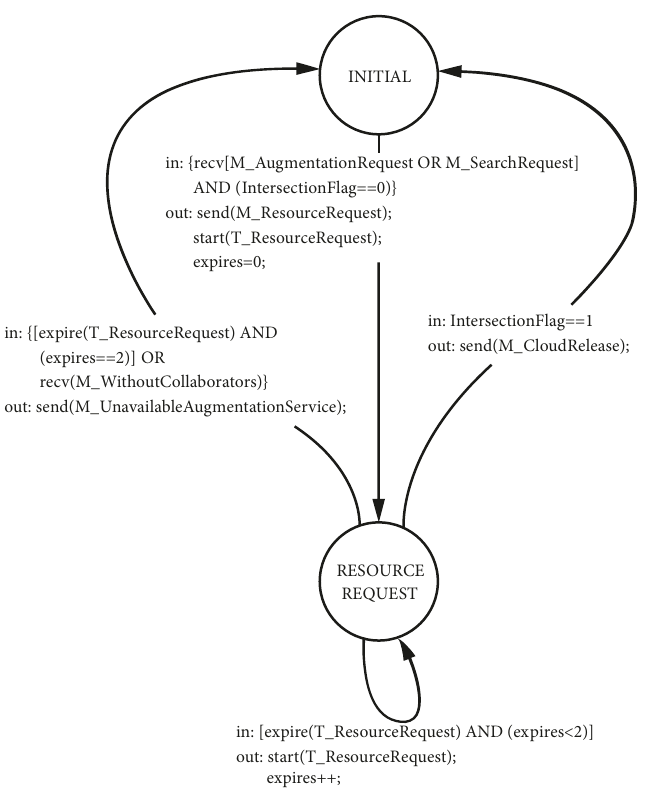
Figure 4: Transition from INITIAL to RESOURCE REQUEST